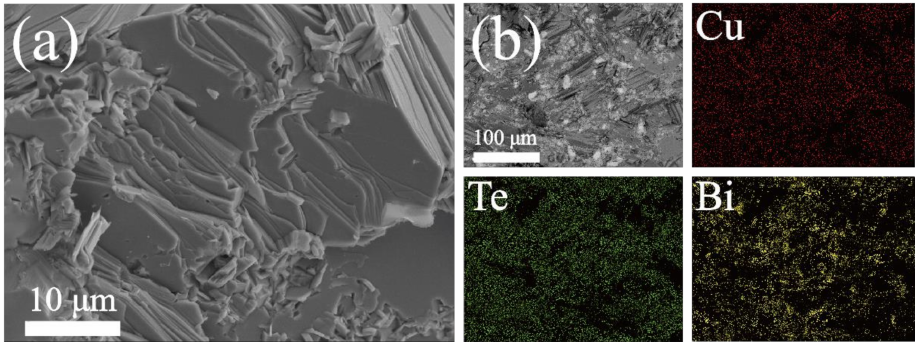
Figure 2. ( a ) FESEM fractography for (Cu 2 Te) 0.9 -(BiCuTeO) 0.1 ; ( b ) EDS for (Cu 2 Te) 0.9 -(BiCuTeO) 0.1 .